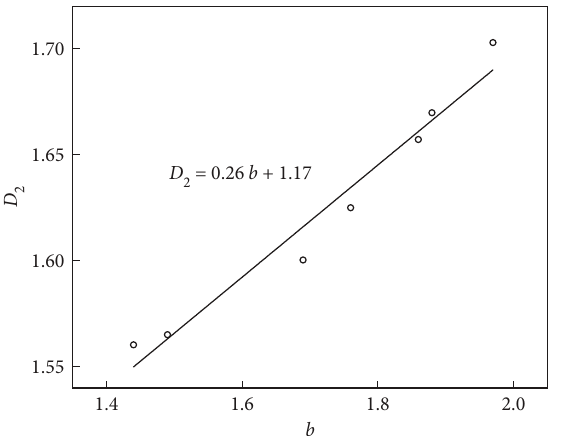
Figure 8: The relationship between fractal dimension D value.